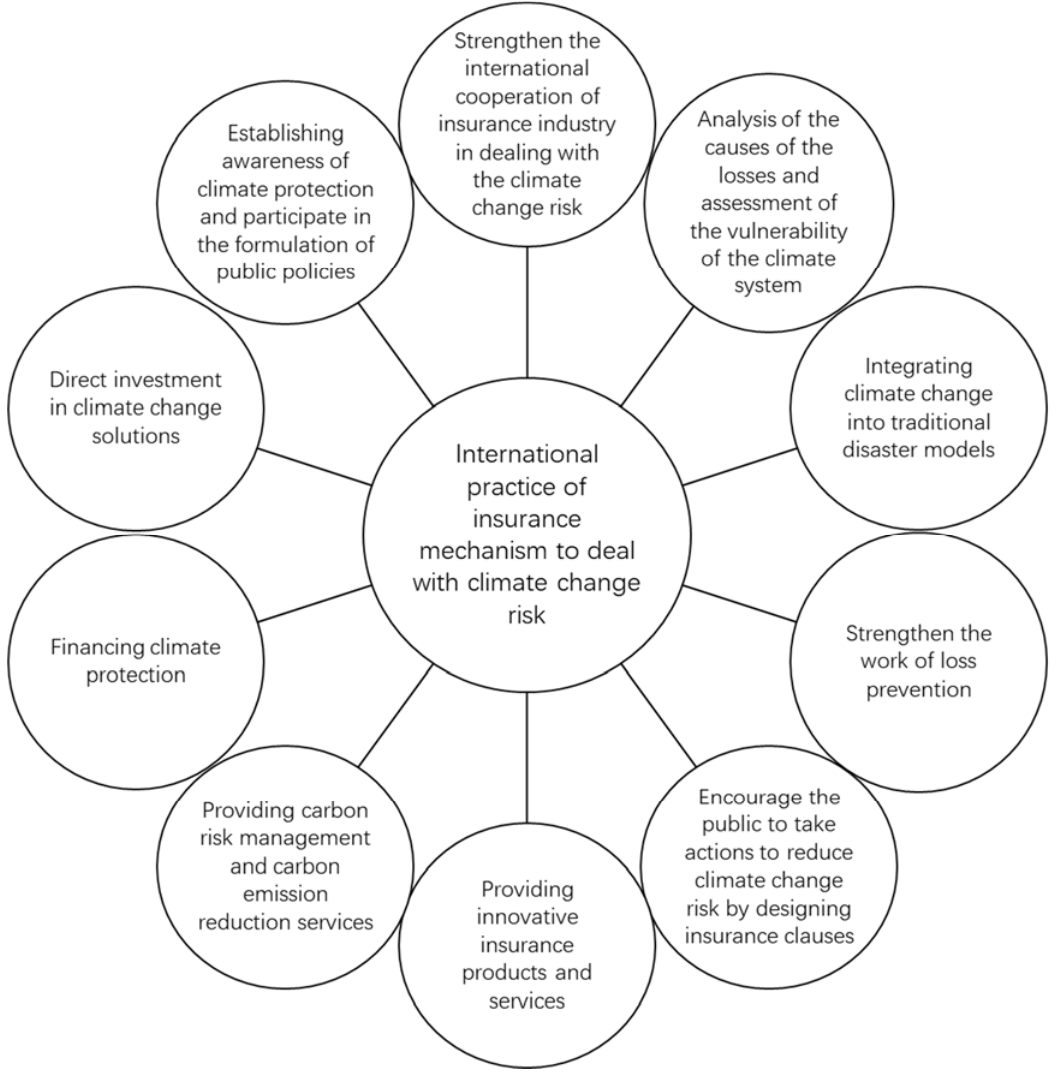
Figure 2. International practice of using insurance mechanism to deal with climate change risk from 10 aspects.